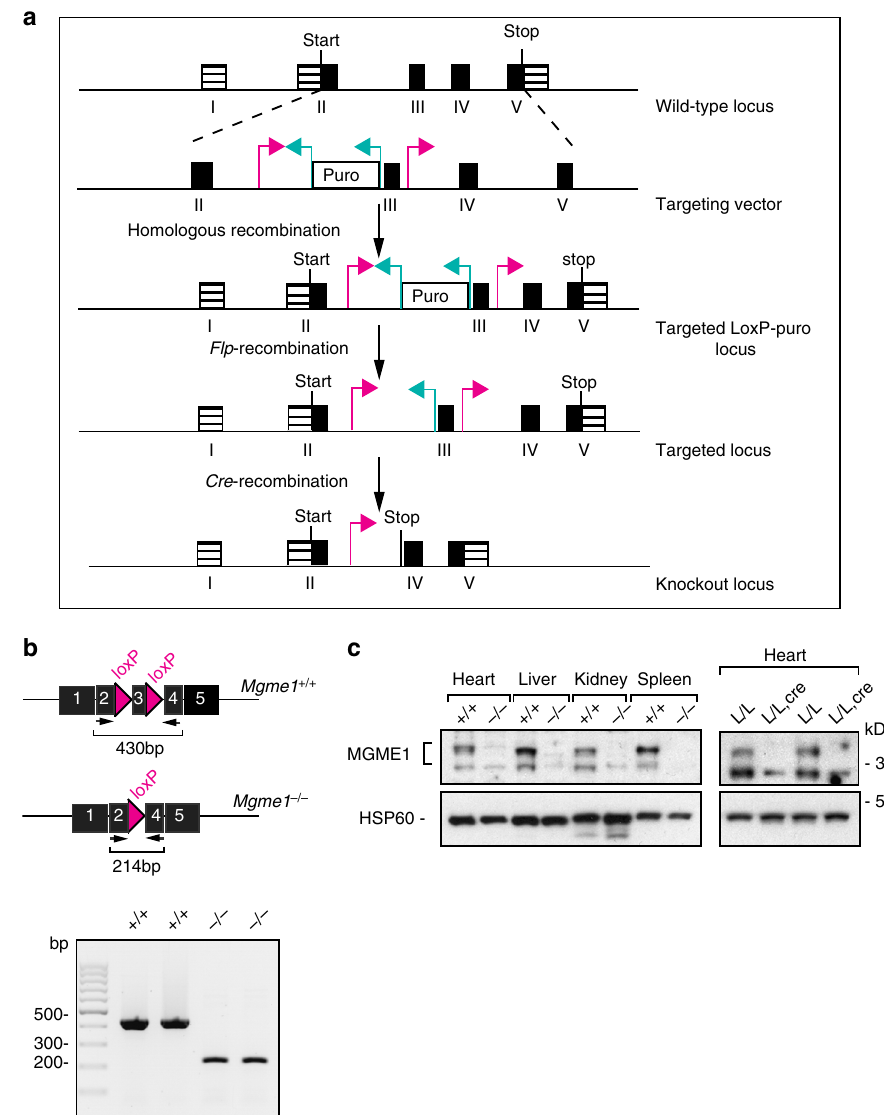
Fig. 1 Conditional knockout of Mgme1 . a Targeting strategy for disruption of the Mgme1 gene. Magenta arrows loxP sequences; turquoise arrows FRT sites. b Schematic representation of Mgme1 cDNA. RT-PCR analysis of Mgme1 transcripts from control ( + / + ) and Mgme1 knockout mice ( − / − ). c Western blot analysis of MGME1 levels in heart, liver, kidney, and spleen mitochondrial extracts of Mgme1 knockout ( − / − ) and wild-type ( + / + ) mice and heart mitochondrial extracts of control ( L/L ) and tissue-speci fi c knockout mice ( L/L, cre ). Mitochondrial HSP60 was used as a loading